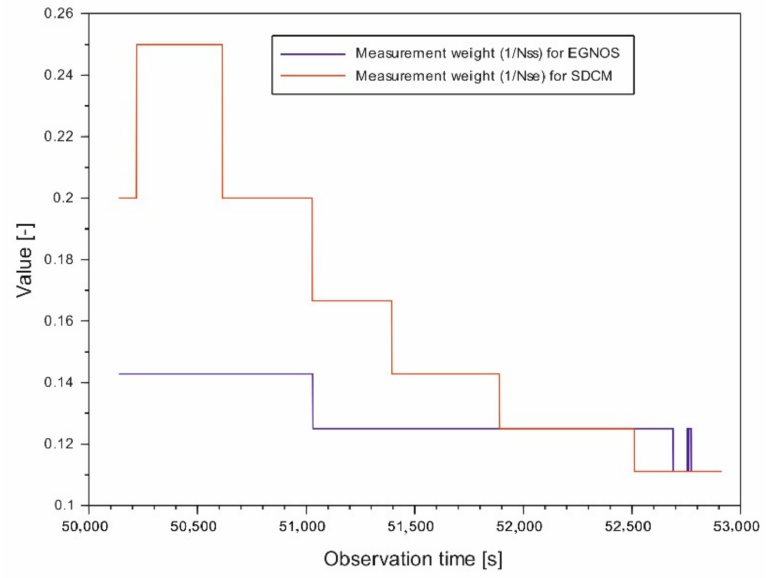
Figure 4. The measurement weights function as the inverse of satellite number (see algorithms (1) and